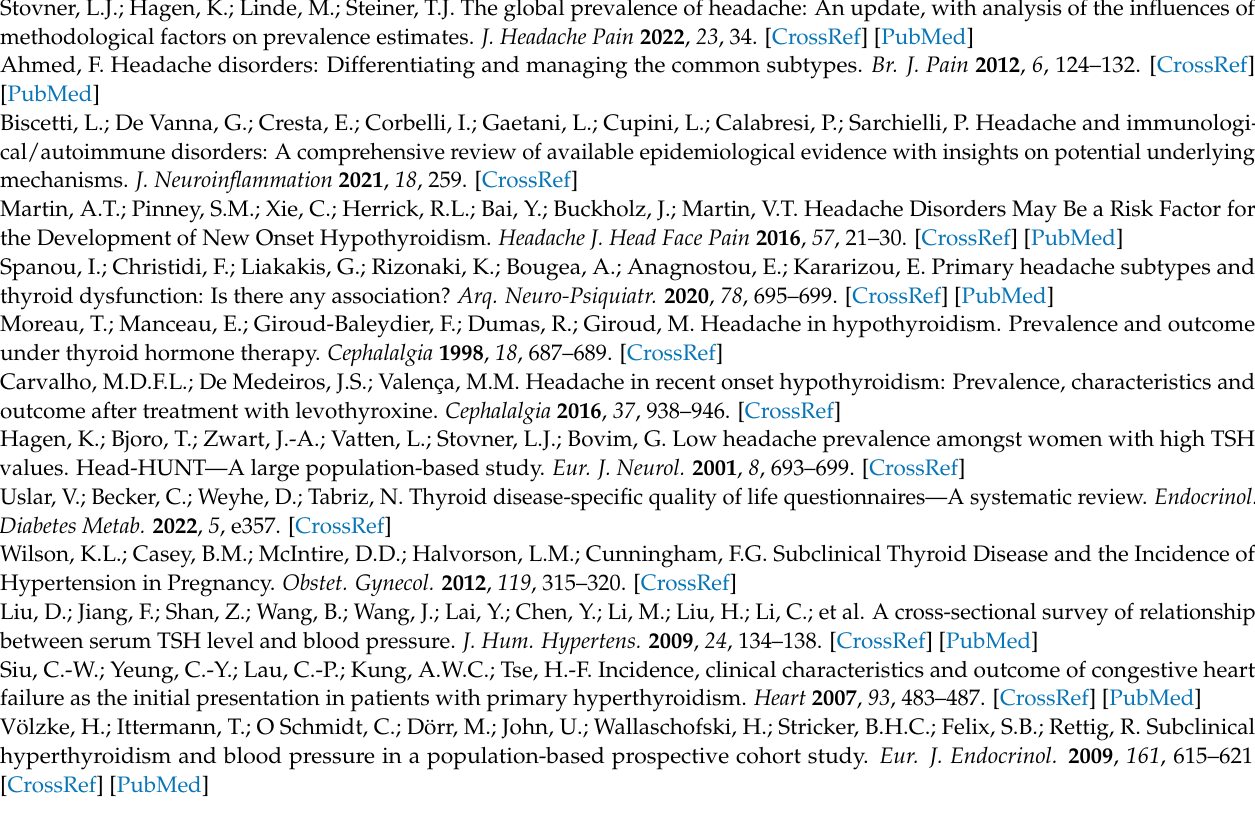
Table S12: Genes overlapping headache and secondary hypothyroidism at p < 0.05 and Fisher com- bined p -value ( p FCP < 2.09 × 10 − 6 ); Table S13: Genes overlapping headache and TSH at p < 0.05 and Fisher combined p -value ( p FCP < 2.09 × 10 − 6 ); Table S14: Genes overlapping headache and fT4 at p < 0.05 and Fisher combined p -value ( p FCP < 2.09 × 10 − 6 ); Table S15: Pathways associated with headache and hypothyroidism; Table S16: Pathways associated with headache and hyperthyroidism; Table S17: Pathways associated with headache and secondary hypothyroidism; Table S18: Pathways associated with headache and TSH; Table S19: Pathways associated with headache and